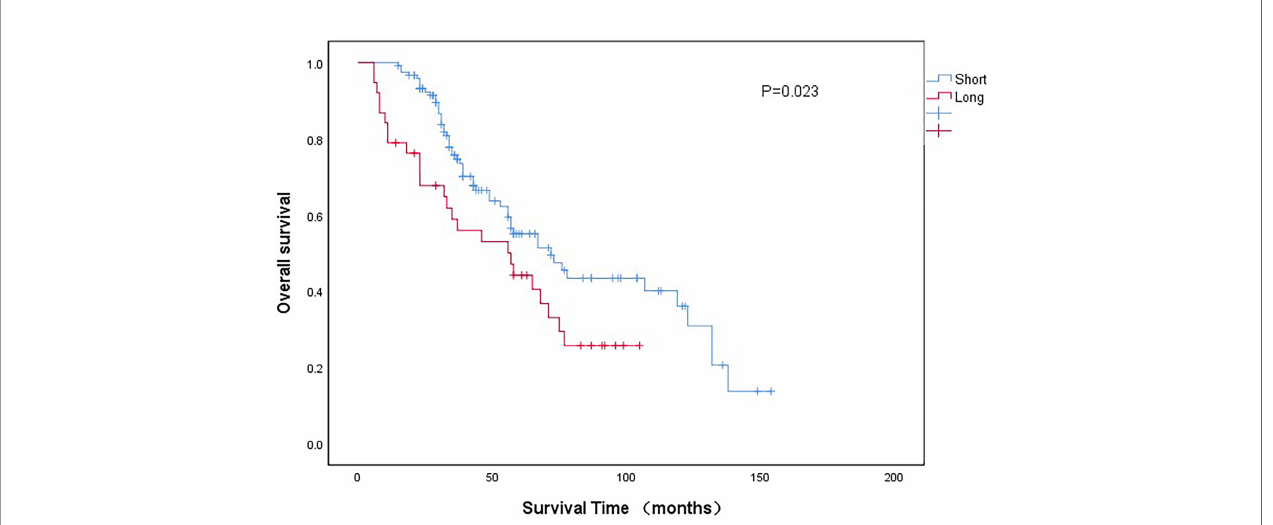
FIGURE 2 | Comparison of overall survival curves between patients with different wait groups.